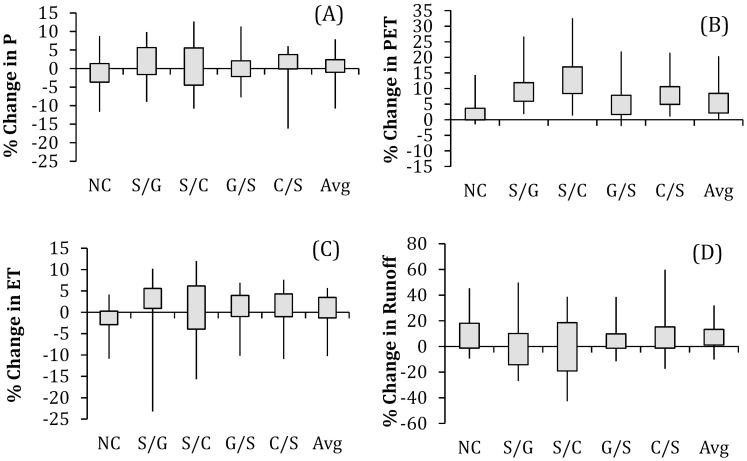
Percent difference in (A) annual precipitation; (B) PET averaged by land use categories in switchgrass altered regions in Kansas and Oklahoma as shown in
Figure 1
.Box top and bottom edges are the interquartile range of percent difference for each year, and whiskers are maximum and minimum annual values. X-axis labels are land use categories: No Change (NC), Switchgrass/Grassland (S/G), Switchgrass/Cropland (S/C), Grassland/Switchgrass (G/S), Cropland/Switchgrass (C/S), and average over all categories (Avg).